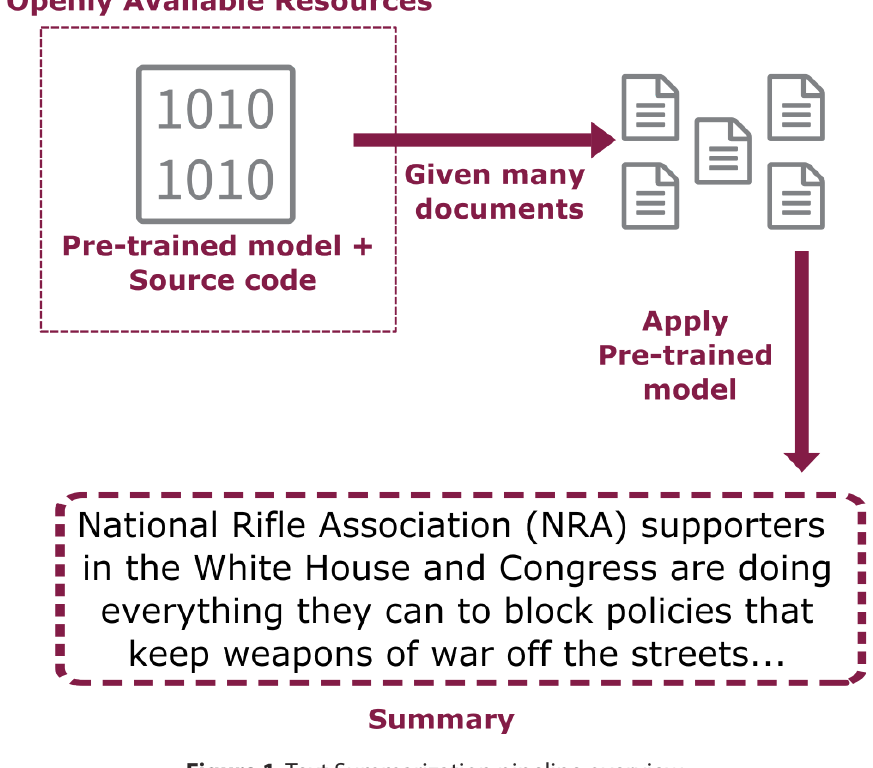
Figure 1 : Text Summarization pipeline